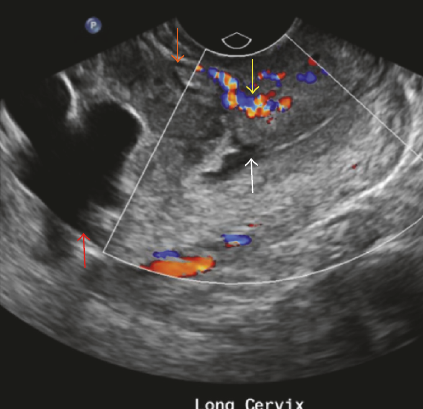
Figure 2: Longitudinal grayscale and color Doppler image of the lower uterine segment and cervix demonstrates endometrial fluid (red arrow) and an irregular, heterogeneously hypoechoic placenta (orange arrow) with blood supply from cervical vessels (yellow arrow) extending into the anterior myometrial wall and over the internal cervical os (white